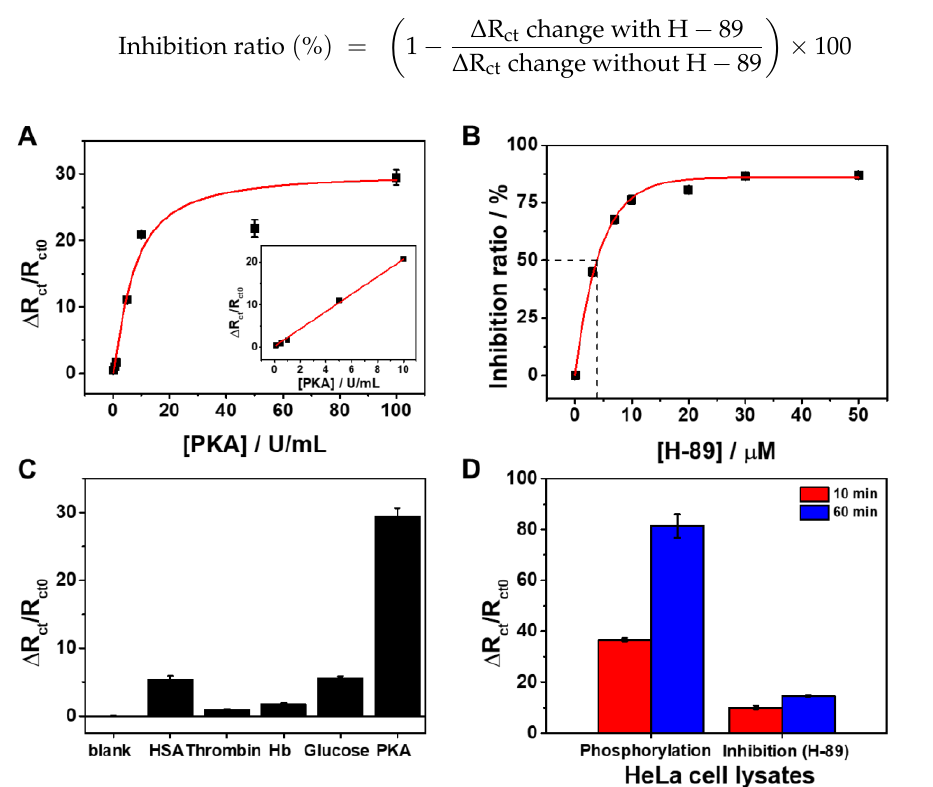
Figure 2. ( A ) ∆ R ct change responses of kemptide/AuE upon the addition of increasing concentration of PKA (0.01, 0.05, 0.1, 0.5, 1, 5, 10, 50, 100 U/mL). ( B ) The inhibition effect of different concentrations of H-89 on the response of kemptide/AuE. ( C ) The interference test of human serum albumin (HSA), thrombin, haemoglobin (Hb), and glucose on the determination of PKA. The PKA concentration was 100 U/mL while other species were 10 mg/mL. ( D ) PKA activity and inhibition assay of the sensor in HeLa cell lysates at incubation time of 10 min (red bars) and 60 min (blue bars) in the absence (left bars) and presence (right bars) of 50 μM H-89. Each experiment was performed in triplicate. Table 1. The comparison of the sensing performance of the proposed biosensor with other meth- ods for PKA.